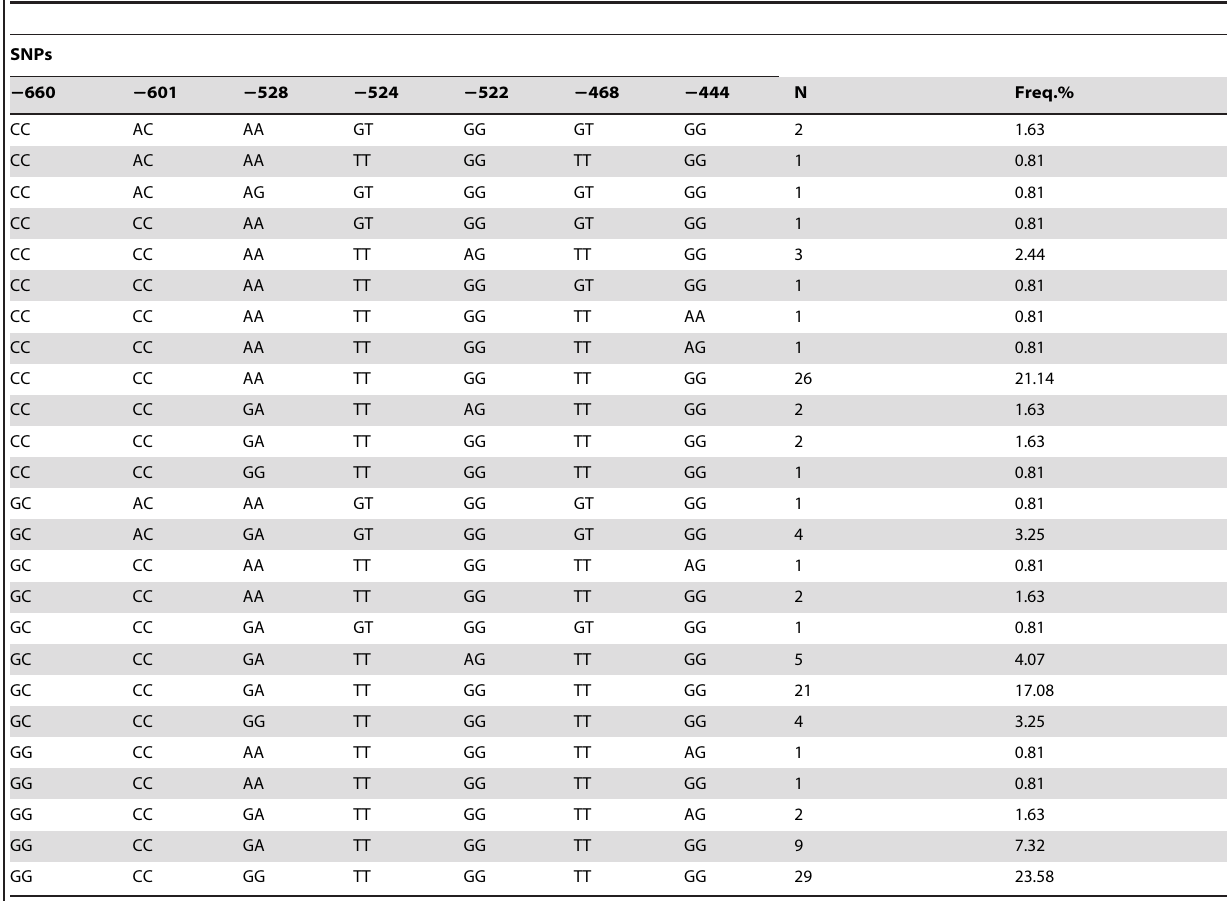
Table 1. Genotype frequencies of the SNPs located at the HSP90AA1 promoter in 120 rams of Manchega sheep